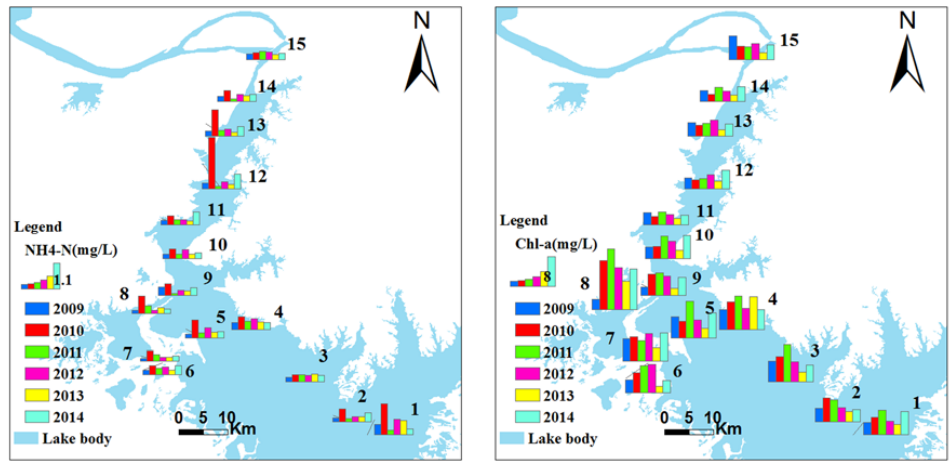
Figure 3. Spatial and annual variations in the total nitrogen (TN), total phosphorus (TP), ammonia nitrogen (NH 4 –N) and chlorophyll–a concentration (Chl–a) of Poyang Lake.